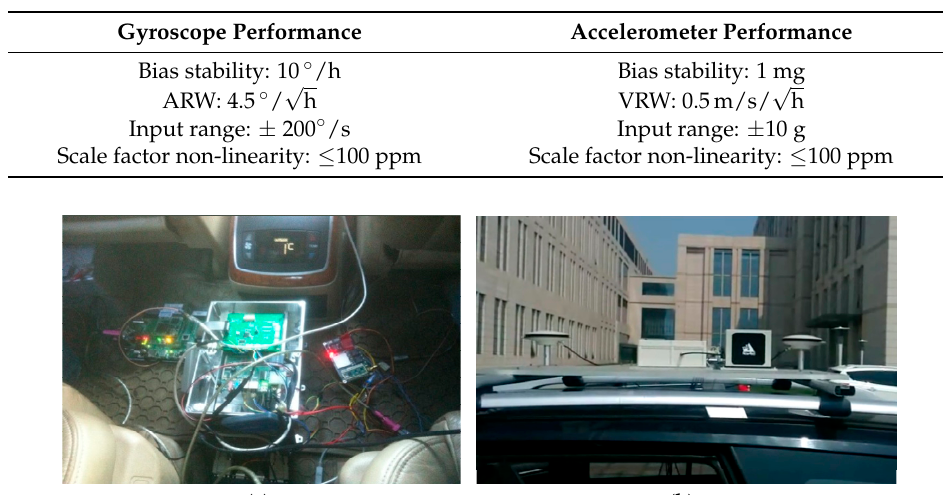
Table 6. The performance parameters of the IMU sensor.